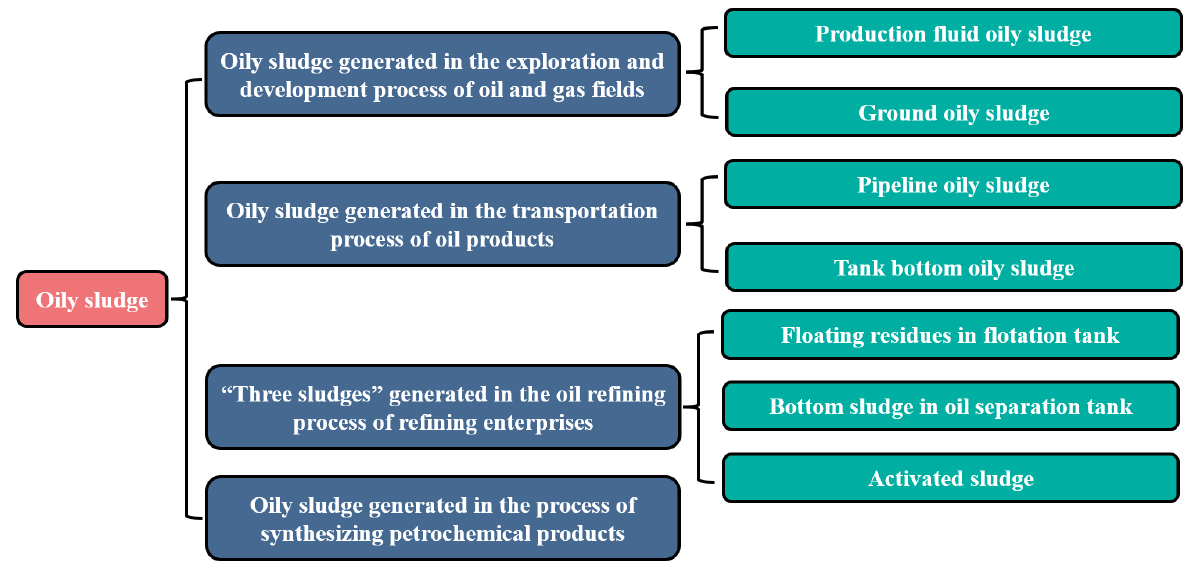
Figure 1. Sources and classification of oily sludge. The characterization of oily sludge samples taken from Shengli Oilfield in